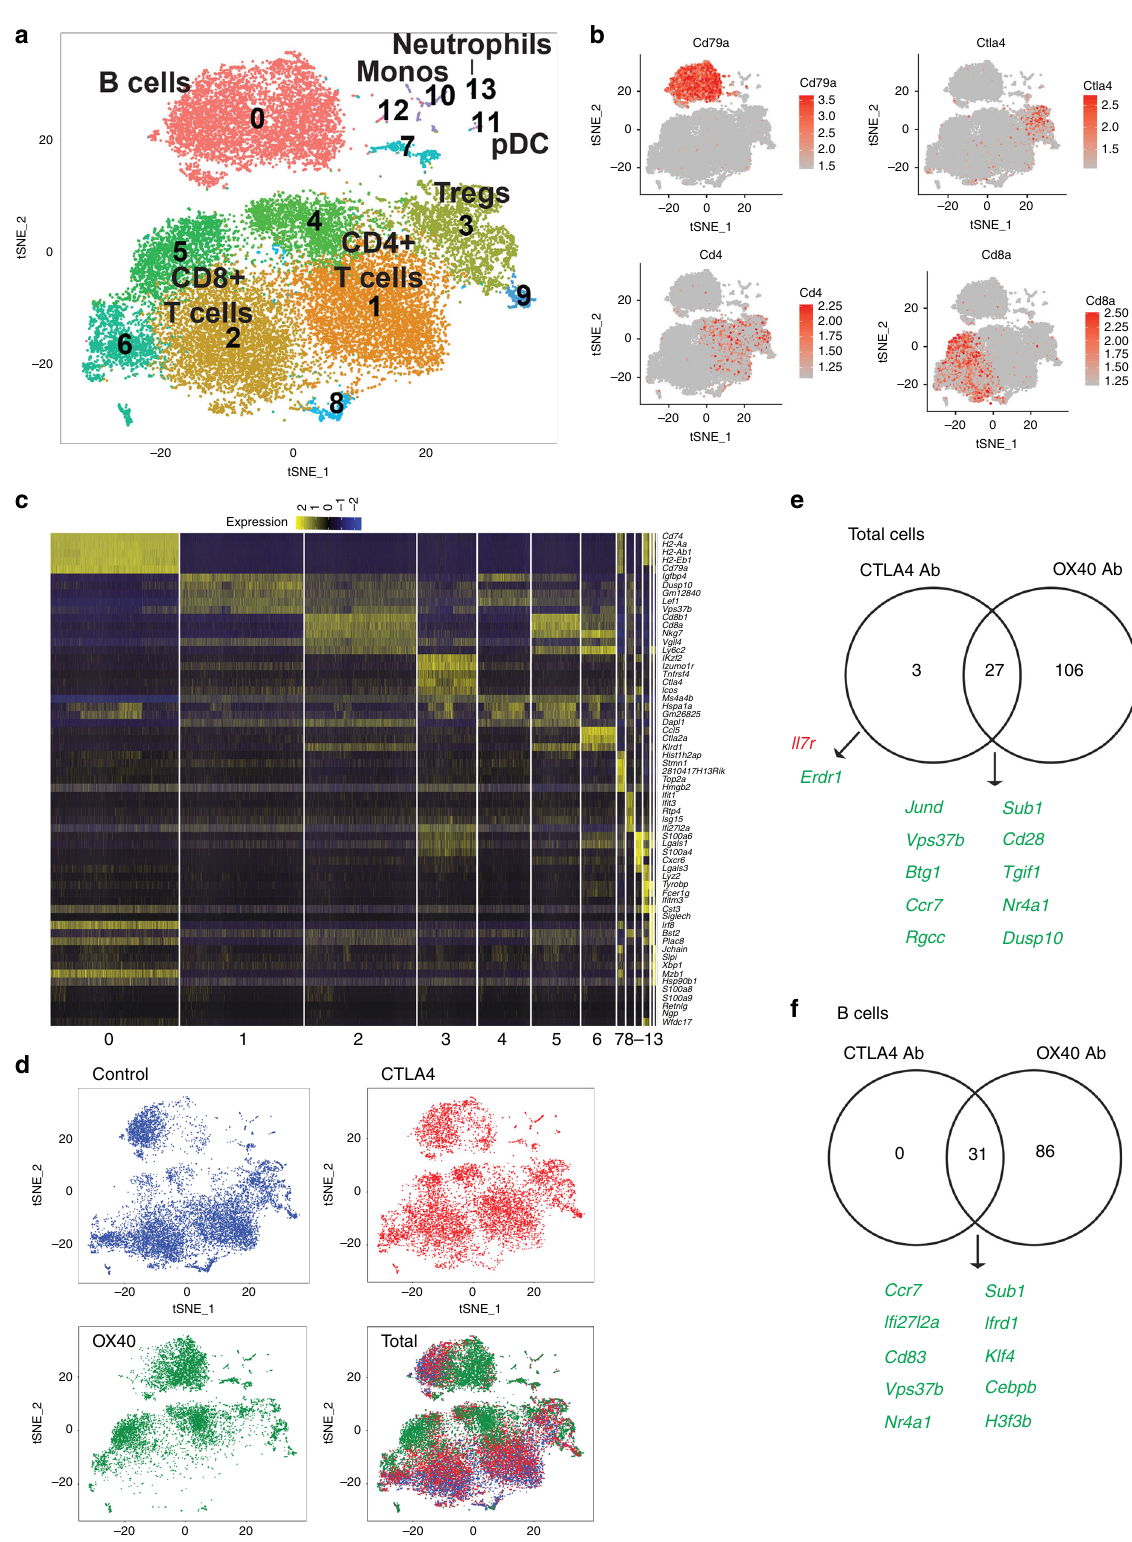
distinct clusters in the B cell, CD4 and CD8 T cell immune cell clusters compared to control cells (blue), suggesting distinct transcriptional changes in OX40 Ab-administered mouse cells (Fig. 7d). Signi fi cantly changed transcripts were determined by comparing CTLA-4 and OX40 Ab to control antibody cells